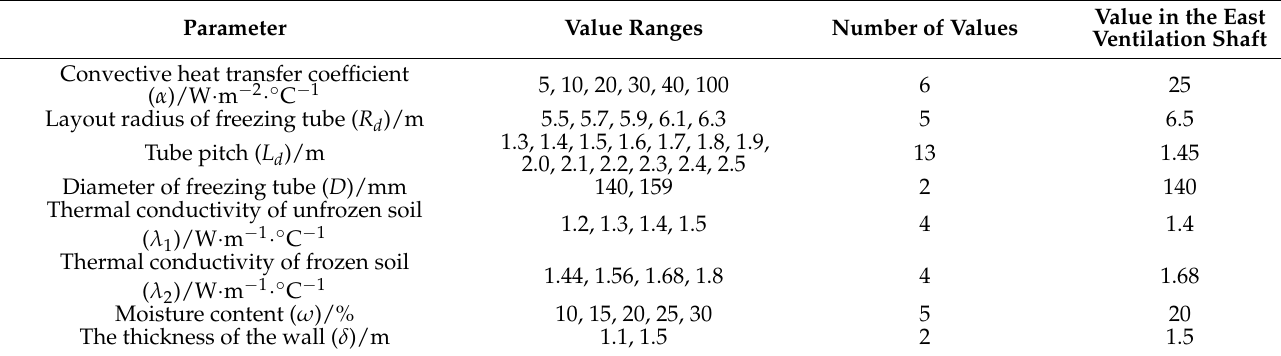
Table 2. Value ranges of each parameter in the single ‐ factor calculation.